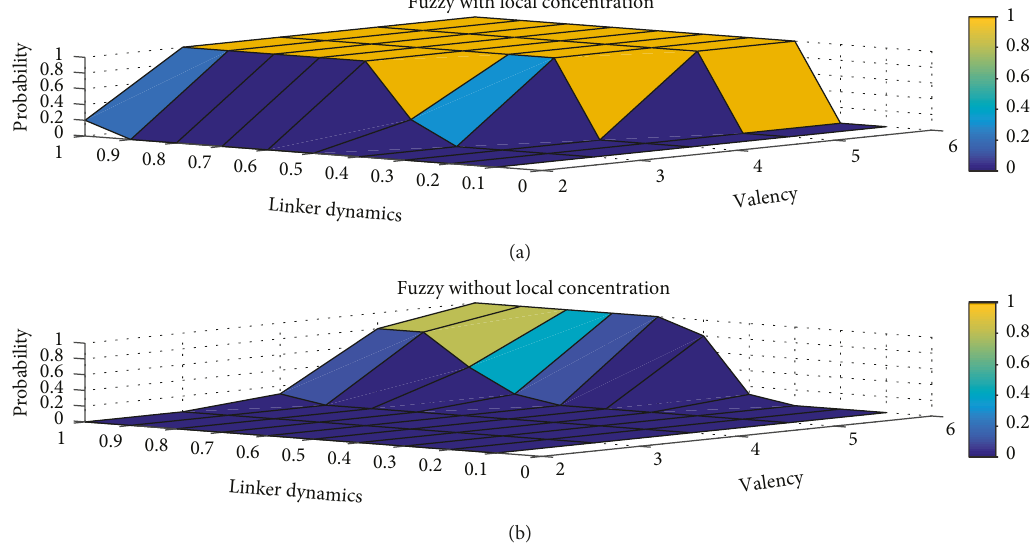
Figure 5: Probability of large polymers as a function of valency and binding a ffi nity in the fuzzy binding model with (a) and without (b) considering the local concentration e ff ect. The local concentration is computed by equation (9). Linker dynamics =0.35; box length=20.